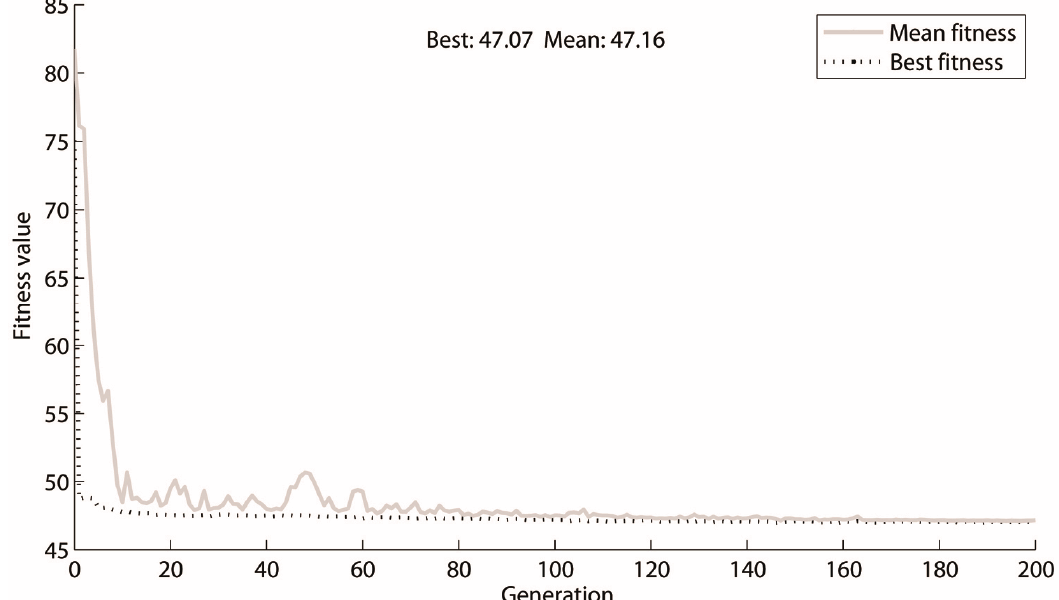
Figure 6. Fitness track of the SAGA